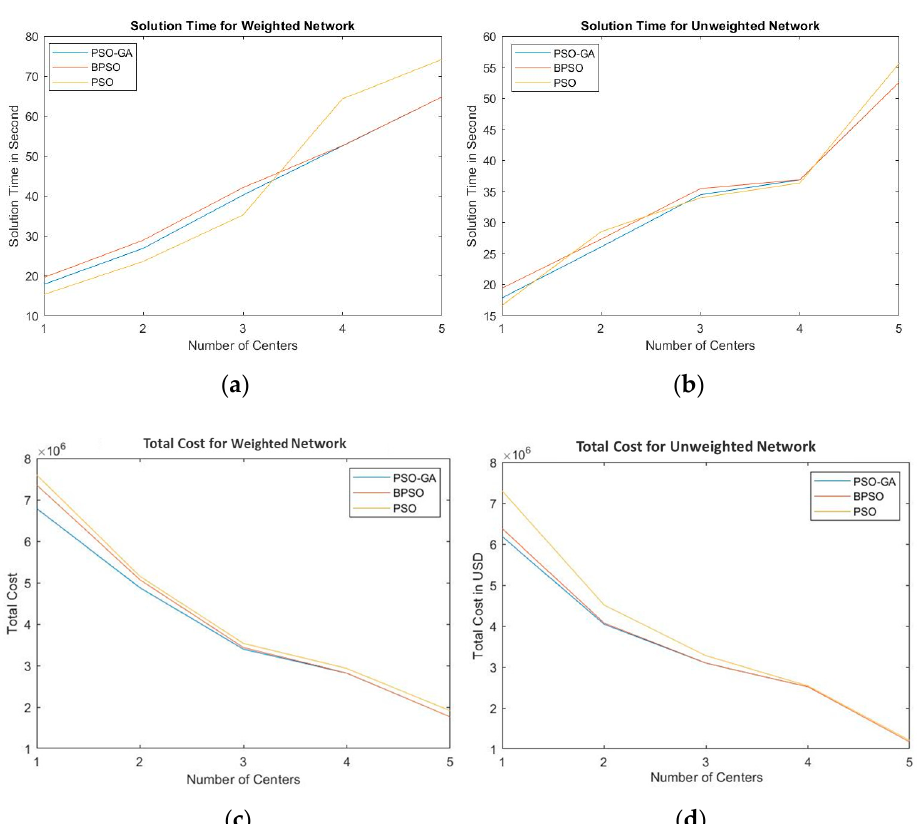
Figure 7. PSO-GA, BPSO, and PSO comparison in Solution Time and Total Cost. ( a ) Solution Time for Weighted Network, ( b ) Solution Time for Unweighted Network, ( c ) Total Cost for Weighted Network, and ( d ) Total Cost for Unweighted Network.